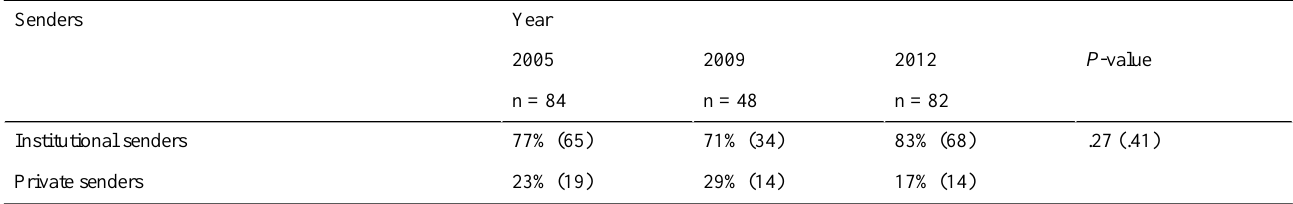
Table 2. The share of search hits on Google on the search term suicide distributed on the variable Senders. In percent (and frequencies). P -values based on Fisher’s exact test for association (and Cochran-Armitage trend statistic in parentheses).